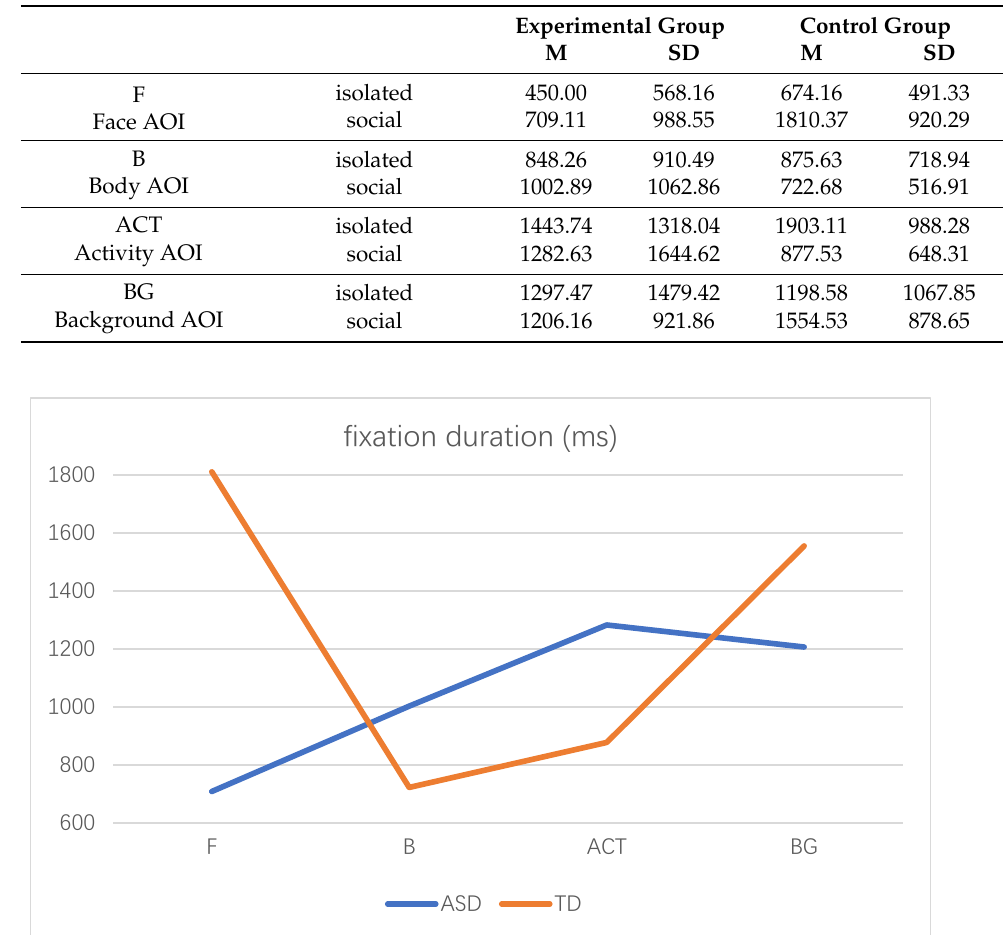
Figure 5. The interaction diagram of the subject category and AOI in the social interaction scene.